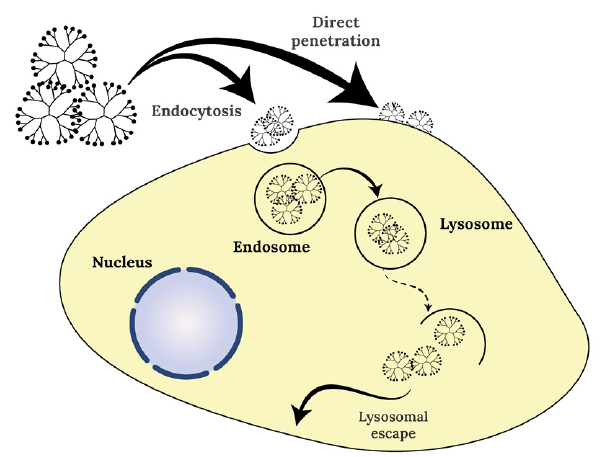
Figure 4. Schematic representation of dendrimer intracellular transportation. In general, dendrimers enter the target cells via direct penetration or endocytosis pathways. At cell level, dendrimers that follow the endocytic pathway are released from endosomes and migrate to lysosomes. Then these macromolecules can be released from lysosomes through a ‘’proton-sponge’’ effect as shown for poly(propylene imine) dendrimers. Adapted from [79].